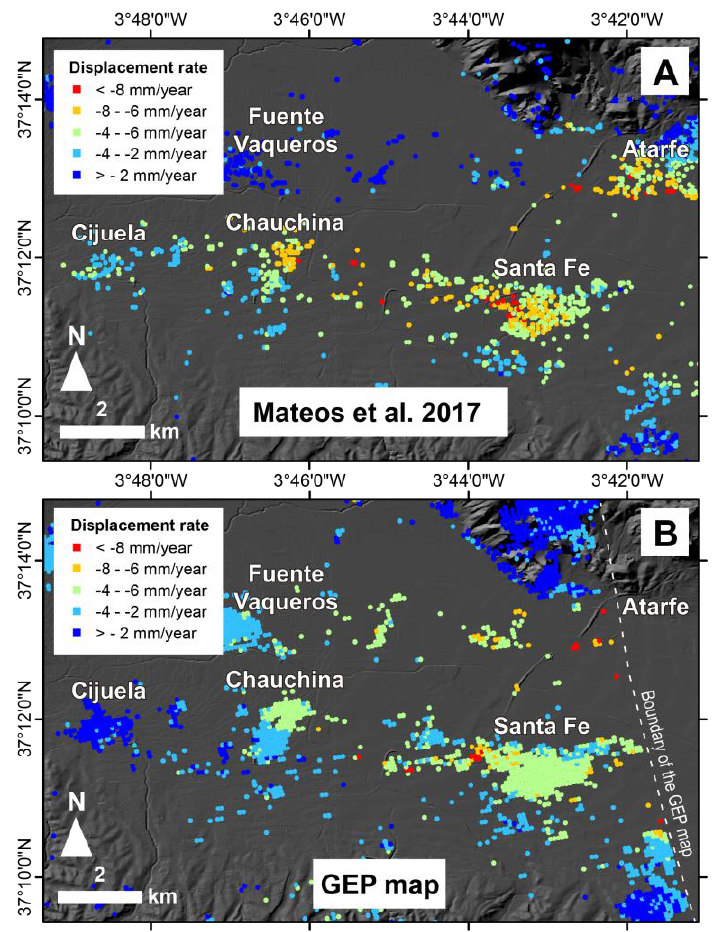
Figure 7. Comparison between the displacement rates measured by Mateos et al. [21] ( A ) and the GEP map ( B ) in the Vega de Granada.